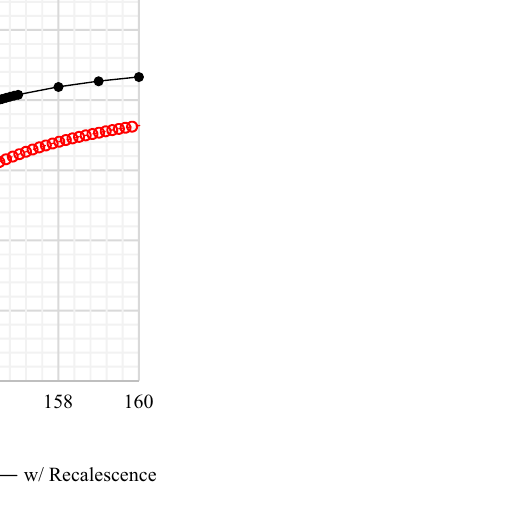
Figure 15. Effect of recalescence on the FCT